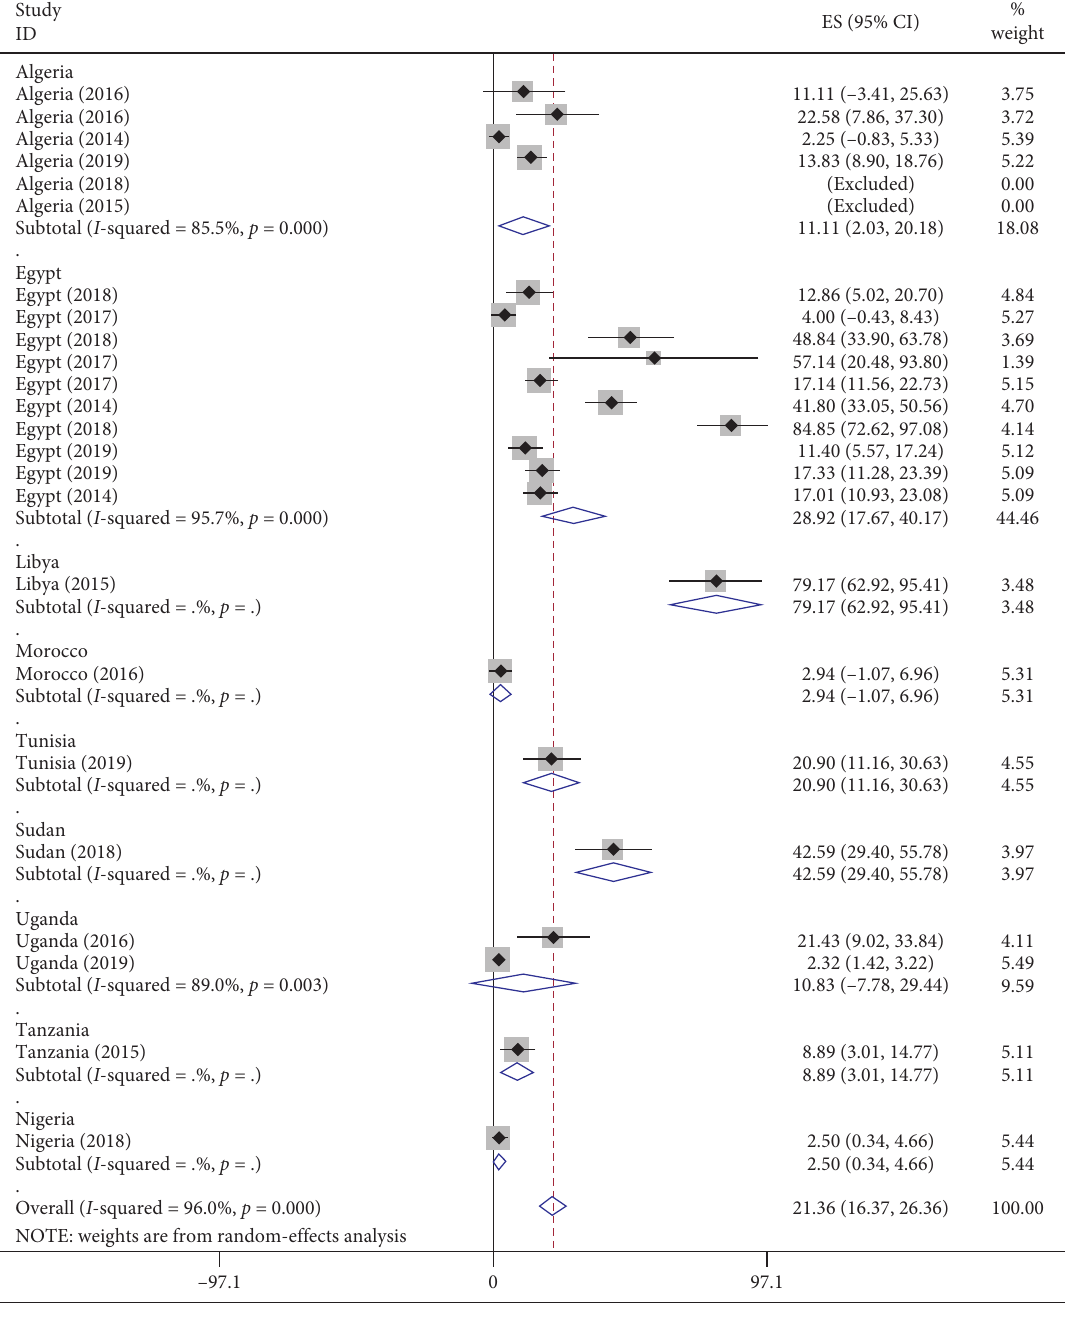
Figure 4: Subgroup analysis for the pooled prevalence of CPPA isolates in Africa by country from 2007 to 2018